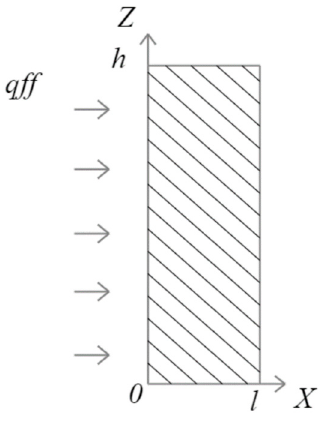
Figure 1. Scheme of the physical model.